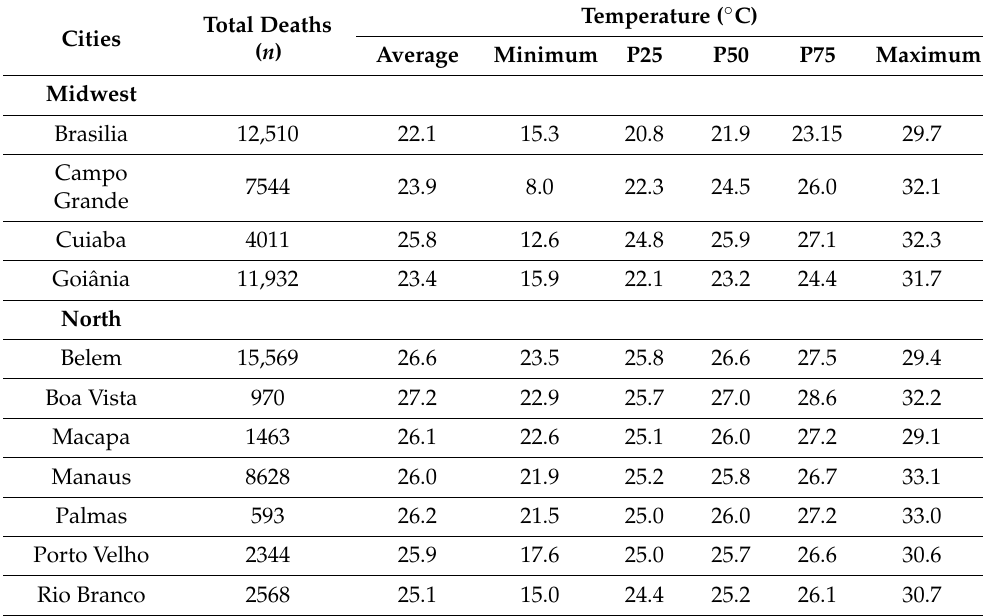
Table 1. Descriptive statistics, total number of deaths and temperature distribution, by state capitals and the entire Brazil, 2000 to